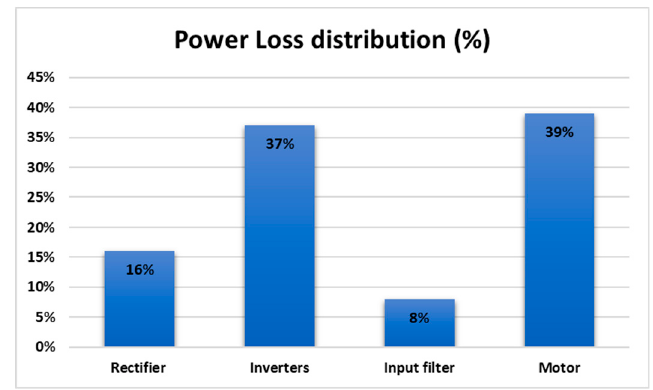
Figure 17. Breakdown of the charger under study.